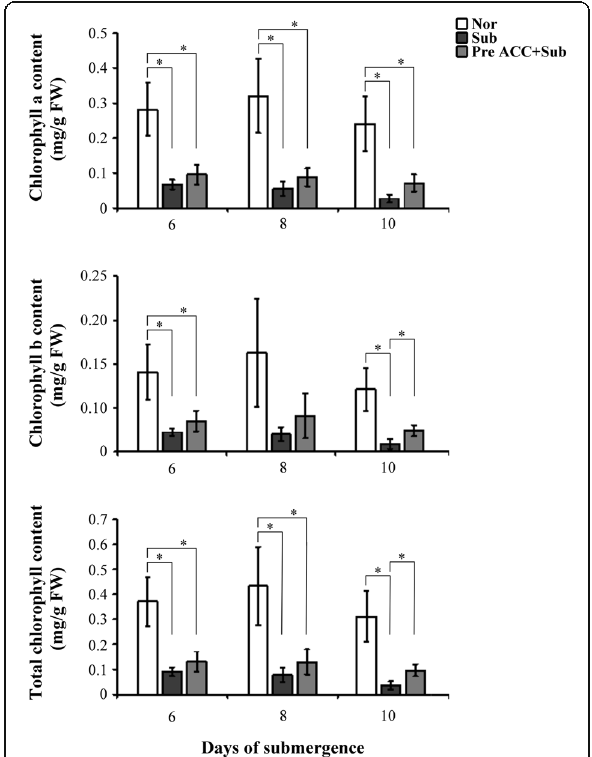
Fig. 3 The chlorophyll content of rice seedlings by pretreatment with an ethylene precursor under submergence conditions. The chlorophyll a, b and total content of 8-day-old TK9 rice seedlings treated under Nor, Sub, and Pre ACC + Sub for 2 days and then subjected to submergence for 4, 6, 8, and 10 days. The data represent the average values ± SD from four biologically independent experiments. The values with asterisk are significantly different at P < 0.05, according to Student ’ s t